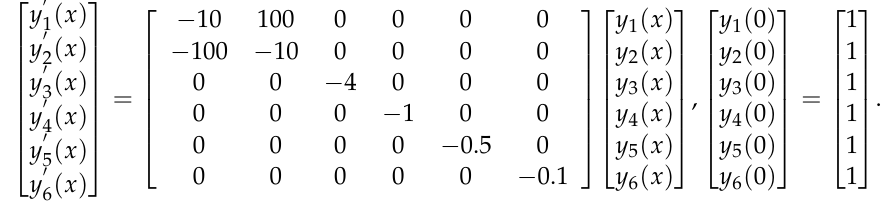
Table 5. Absolute errors of numerical integration of Example